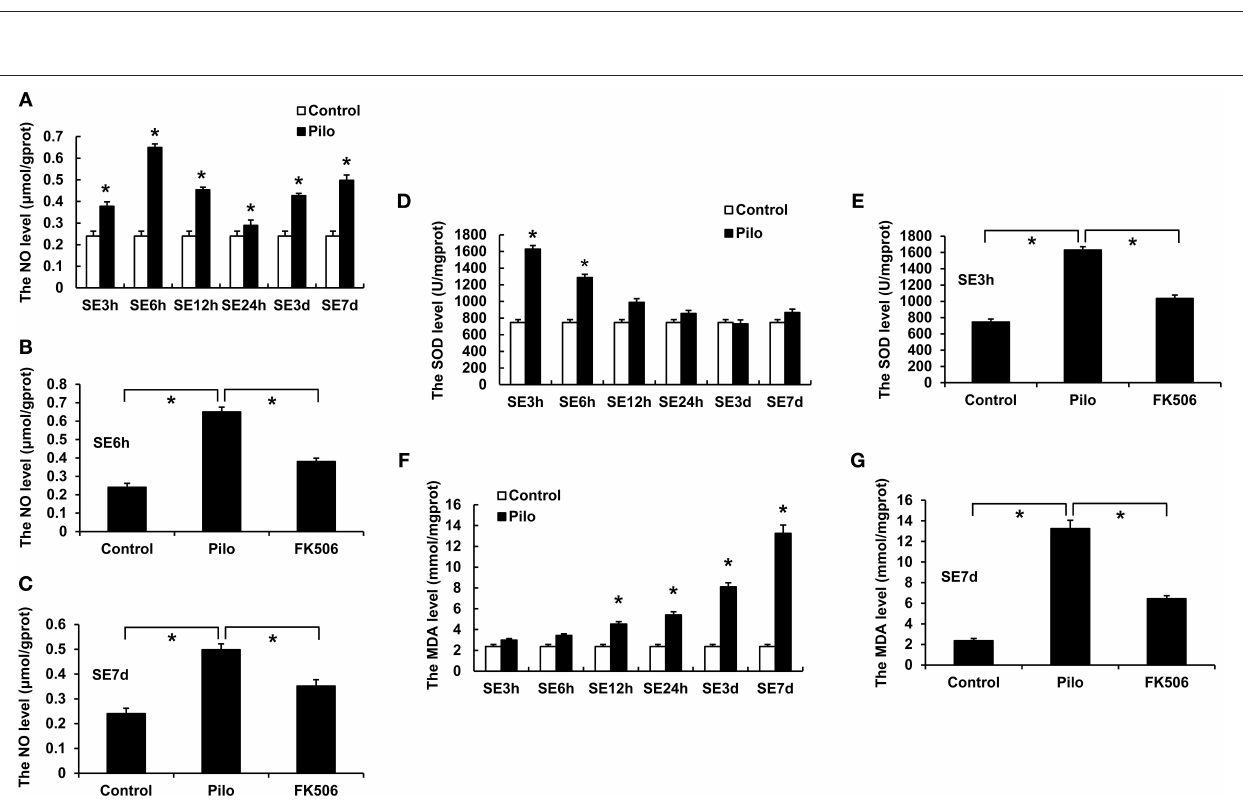
FIGURE 2 | Changes of NO, MDA, and SOD in the hippocampus of rats in different treatment groups. (A) Changes of NO at different time points in the control group and the epilepsy group. (B) Changes of NO in the control group, epilepsy group, and FK506 group after 6h of modeling. (C) Changes of NO in the control group, epilepsy group, and FK506 group after 7 days of modeling. (D) Changes of SOD at different time points in the control group and the epilepsy group. (E) Changes of SOD in the control group, epilepsy group, and FK506 group after 3h of modeling. (F) Changes of MDA at different time points in the control group and the epilepsy group. (G) Changes of MDA in the control group, epilepsy group, and FK506 group after 7 days of modeling. * P < 0.05.